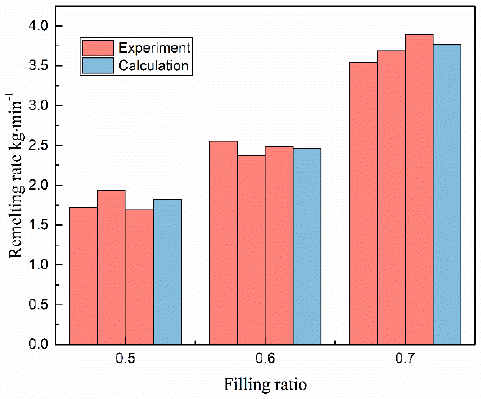
Figure 5. The in situ experiment of the TSCE-ESR process. ( a ) Electrode drop in the TSCE-ESR process. ( b ) Shape of the electrode tip in the TSCE-ESR experiment.